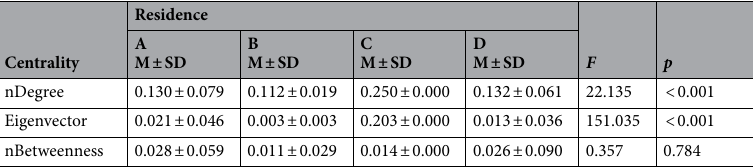
Table 2. One-way analysis of variance (ANOVA) of centrality measures (nDegree, eigenvector and nBetweenness) by